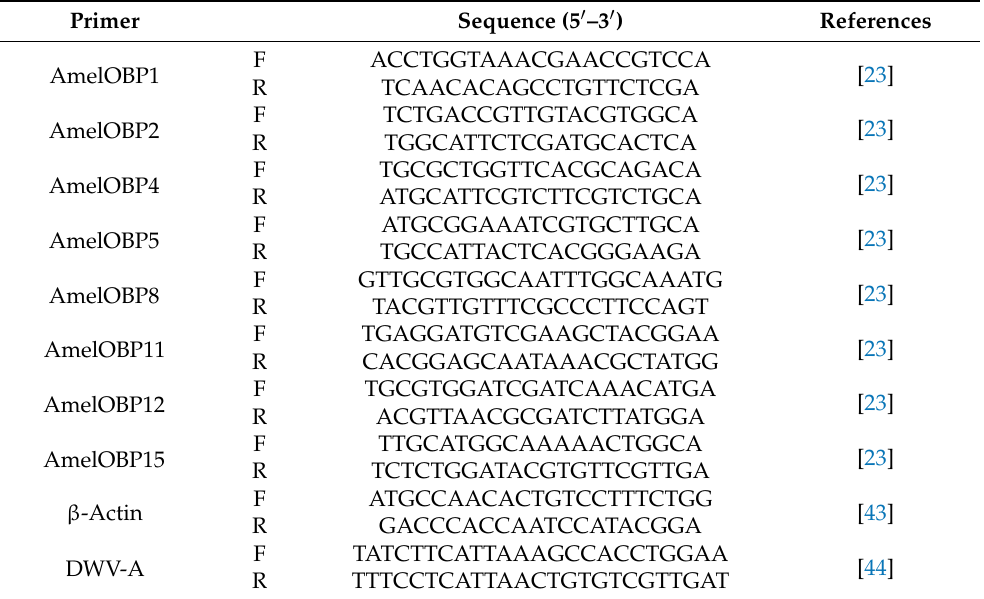
Table 1. Primers used in the qPCR amplification for the odorant binding proteins (OBPs), the β - Actin gene, and specific primer to variant A of deformed wing virus (DWV-A). Primer Sequence (5 (cid:48) –3 (cid:48) )